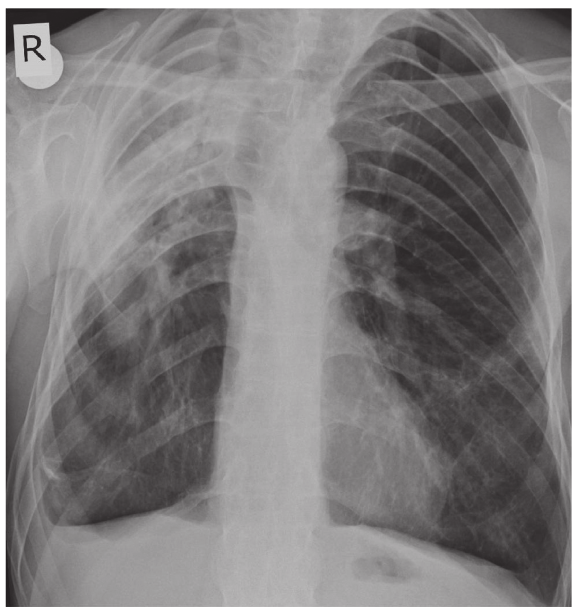
Figure 1: Chest X-ray shows diffuse opacities in the upper zone of the right lung. Also, it reveals deviation of the trachea to the right side and blunting of the right costophrenic